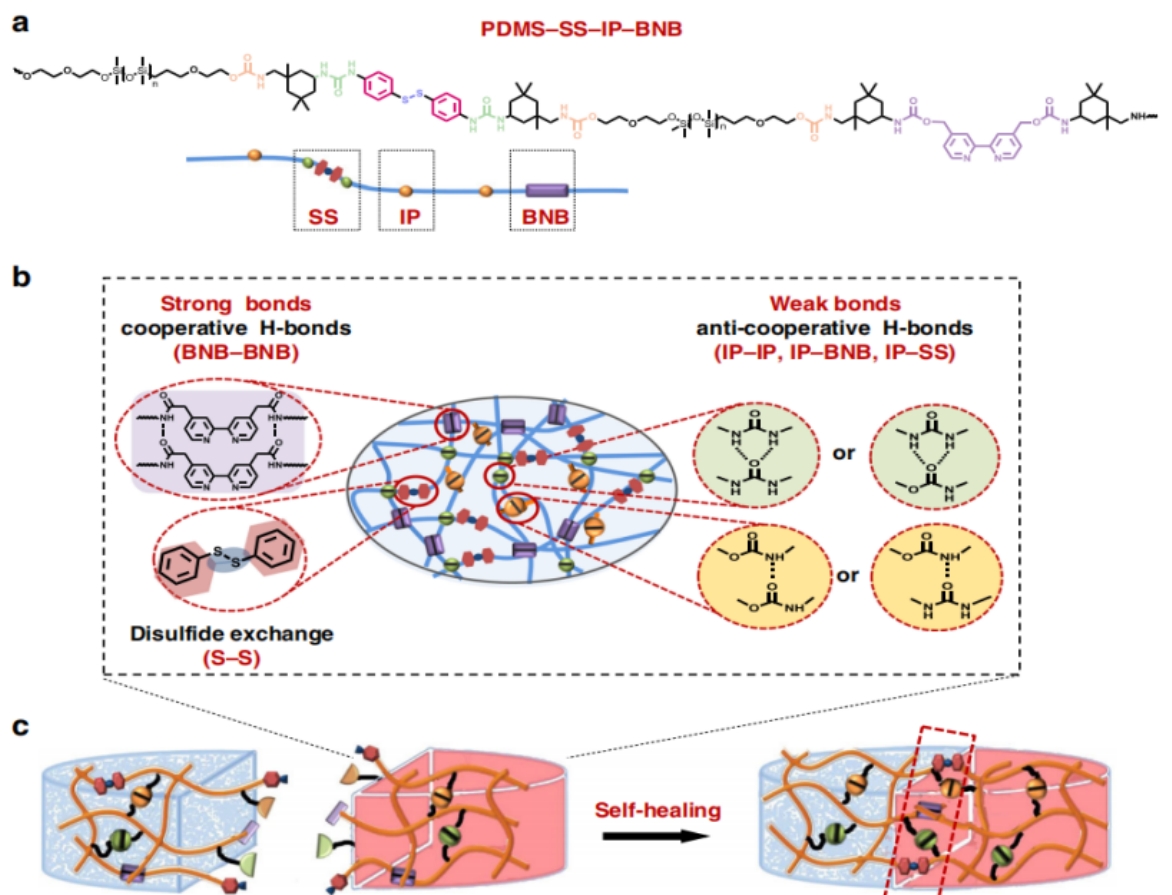
Figure 11. Molecular design of the PDMS-SS-IP-BNB elastomer with high toughness, stretchability and universally autonomous self-healing ability. ( a ) Chemical structure of PDMS-SS-IP-BNB. ( b ) The proposed ideal structure of the supramolecular polymer network based on strong crosslinking H- bonds (BNB-BNB), weak crosslinking H-bonds (IP-IP, IP-BNB, IP-SS) and disulfide metathesis (S-S). ( c ) The synergistic interaction of multiple dynamic bonds contributes to the universally self-healing capability of elastomers. Reprinted with permission from [113]. Copyright 2020 Springer